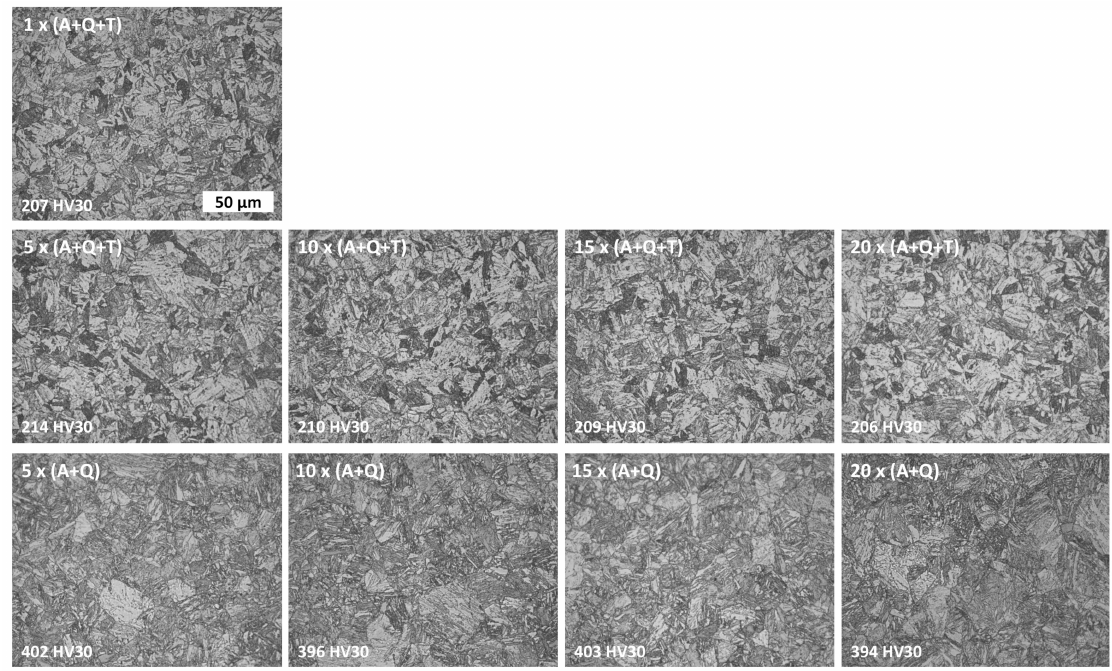
Figure 8. The effect of multiple heat treatments on the microstructure of EUROFER97/2 (25 mm plate, heat 993402). The optical micrographs show cross-sections of the plane T-S. Vickers hardness was measured on T-S cross-sections, too. The values are given in the lower left corner of the images. The heat treatment is indicated as follows: austenitization at 980 ◦ C for 30 min (A), air quenching (Q), and tempering at 750 ◦ C for 2 h